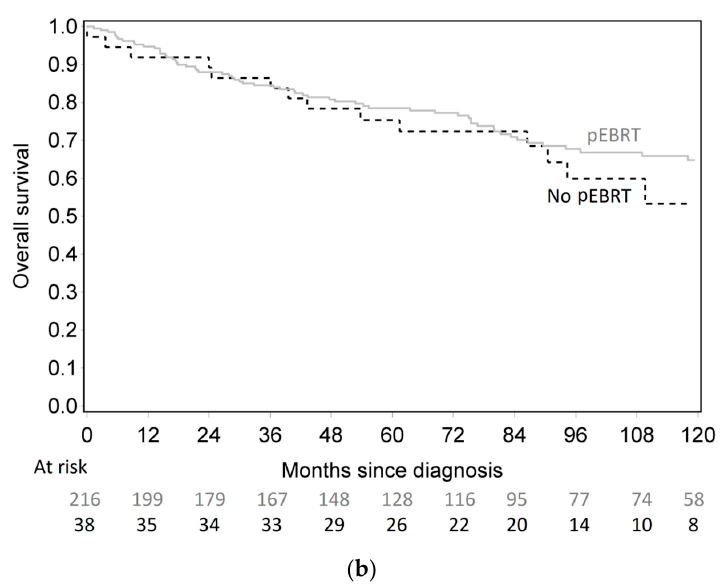
radiotherapy (pEBRT )and surgery group. ( b ) Overall survival according to pEBRT and surgery Figure 1. ( a ) Cumulative incidence of locoregional failure according to postoperative external beam group. radiotherapy (pEBRT) and surgery group. ( b ) Overall survival according to pEBRT and surgery group.